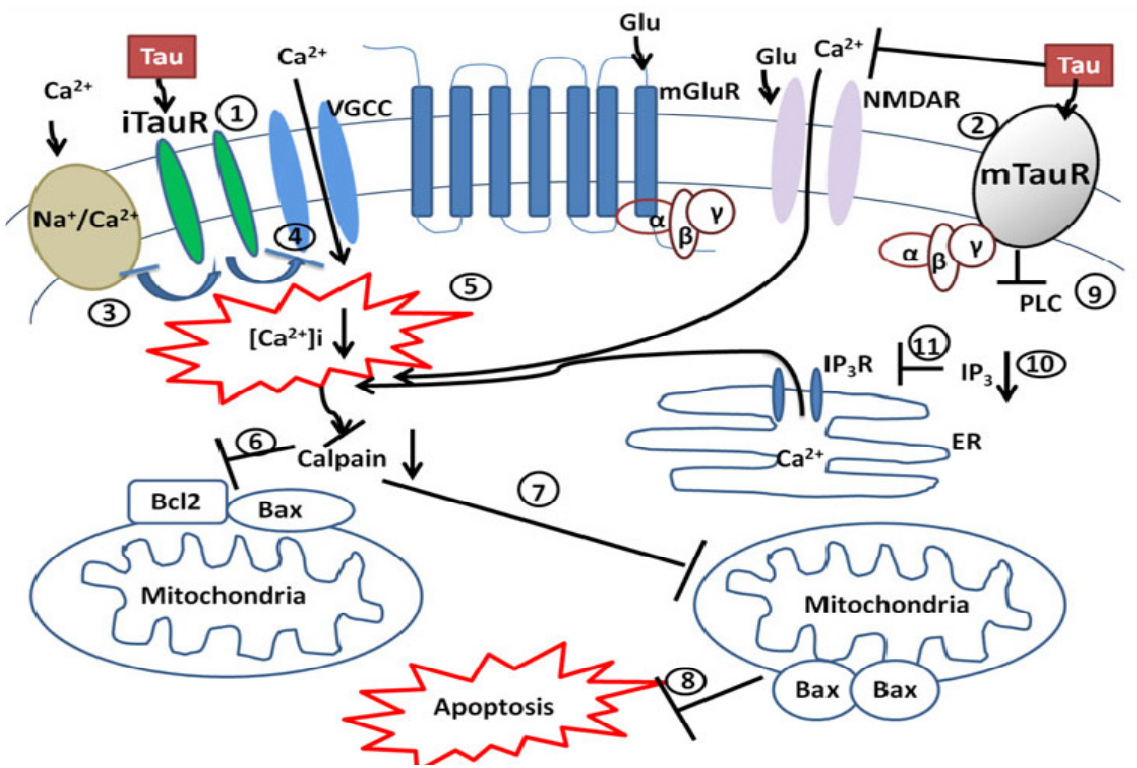
Figure 3. Schematic depiction of taurine neuroprotective mechanisms via putative taurine receptors. ( 1 ) Activated ionotropic taurine receptor (iTauR) and/or ( 2 ) metabotropic taurine receptor (mTauR) inhibits ( 3 ) the reverse mode of the sodium/calcium exchanger; ( 4 ) inhibition of voltage-gated calcium channels (VGCC) due to taurine induced hyperpolarization, decreases ( 5 ) intracellular calcium. Reduction in intracellular calcium inhibits calpain, eliciting the inhibition of ( 6 ) calpain-induced cleavage of Bcl-2 and Bax. ( 7 ) Bax homodimer is inhibited, resulting in the inhibition of the ( 8 ) mitochondrion-mediated death cascade. ( 9 ) Phospholipase C (PLC) is inhibited by activated mTauR (mTauR: is coupled to inhibitory G-protein), resulting in ( 10 ) decreased IP production, which attenuates ( 11 ) the release of calcium from the 3